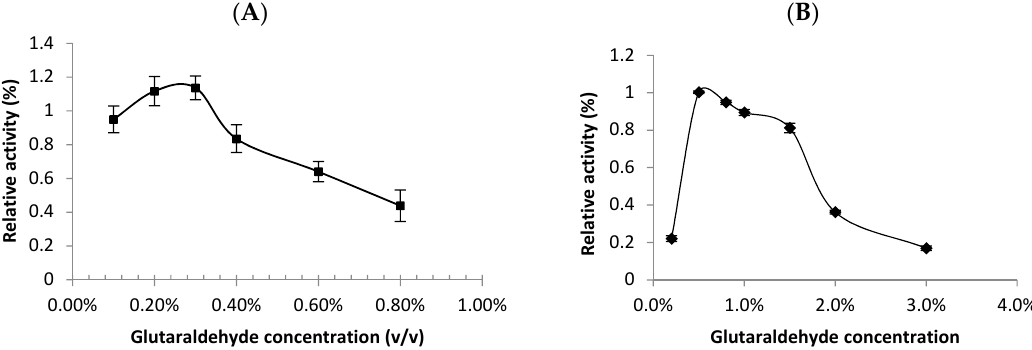
Figure 2. ( A ) Effect of glutaraldehyde on CLEA activity. Assuming the initial activity of free enzyme was 100%. ( B ) Effect of glutaraldehyde on CLEA-bovine serum albumin (CLEA-BSA) activity (50 mg of BSA was added in 1 mL α -amylase solution). Assuming the initial activity of free enzyme was 100%.